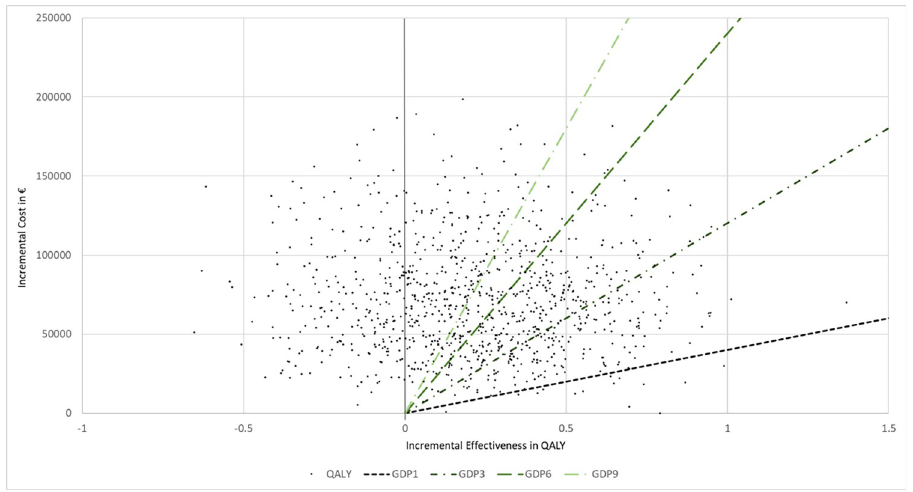
Fig 3. ICER scatterplot with willingness-to-pay thresholds according to GDP per capita. QALY = quality-adjusted life year; GDP3 = gross domestic product times